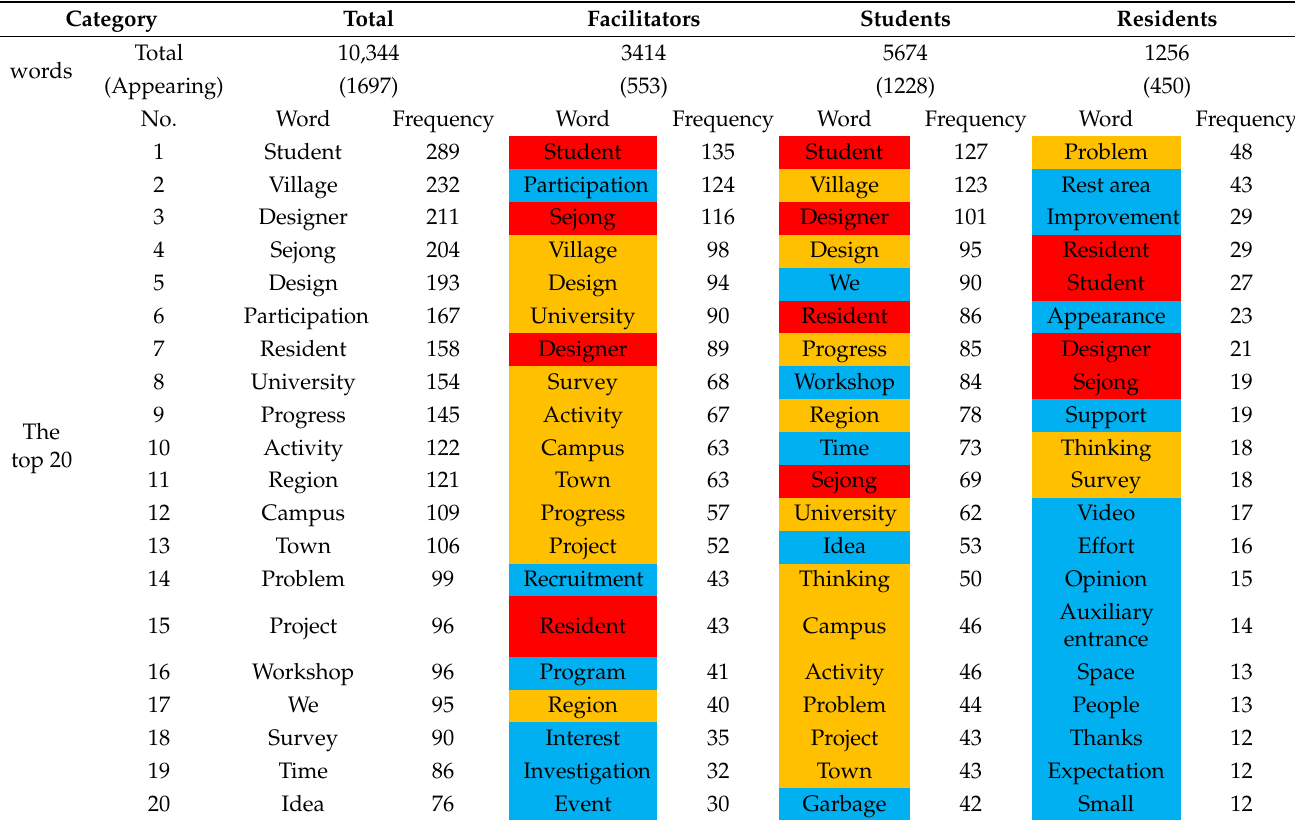
Table 2. Frequency of words (nouns) mentioned by each participant.